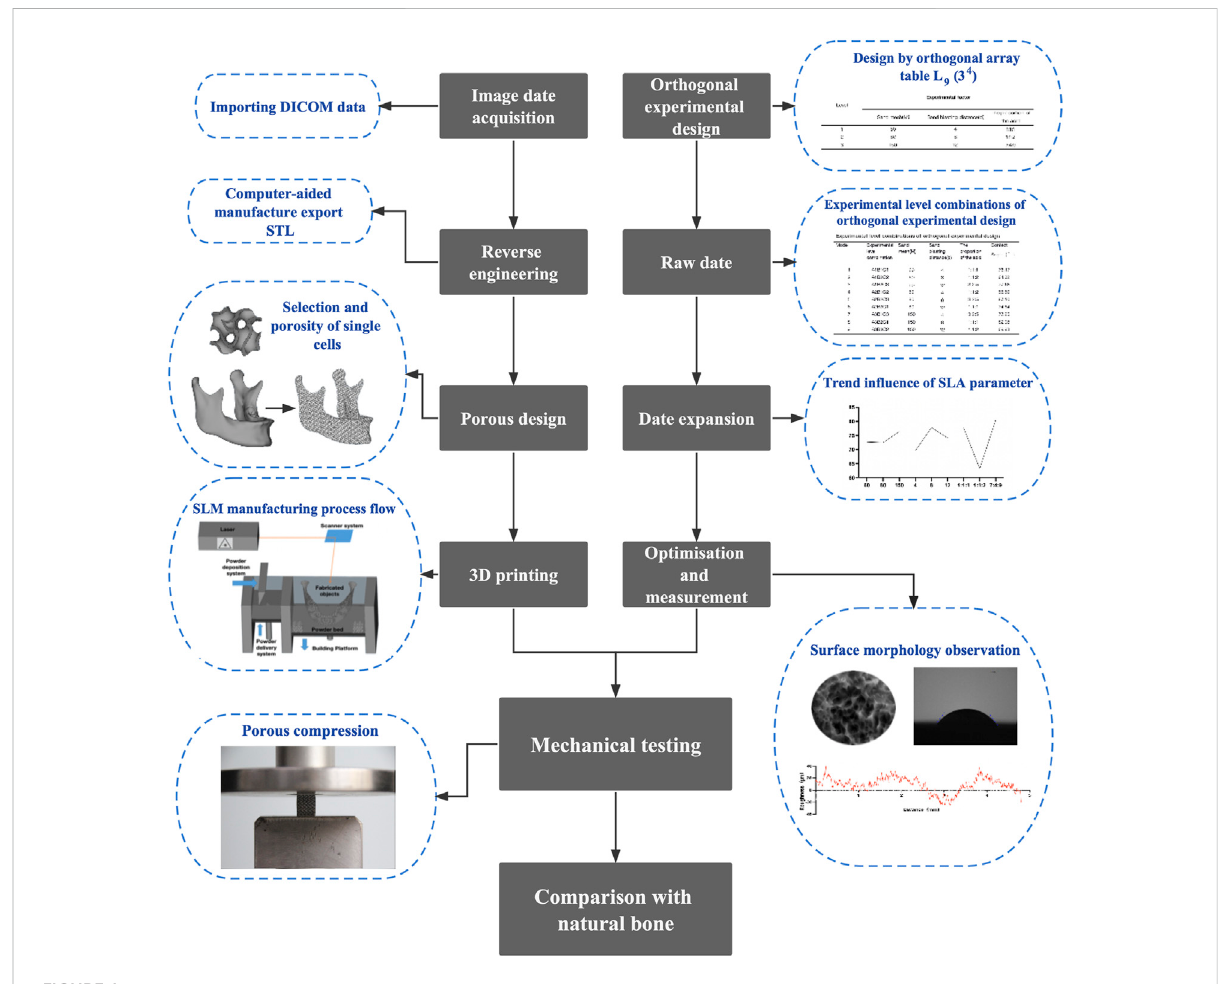
FIGURE 1 Flow chart of the experimental